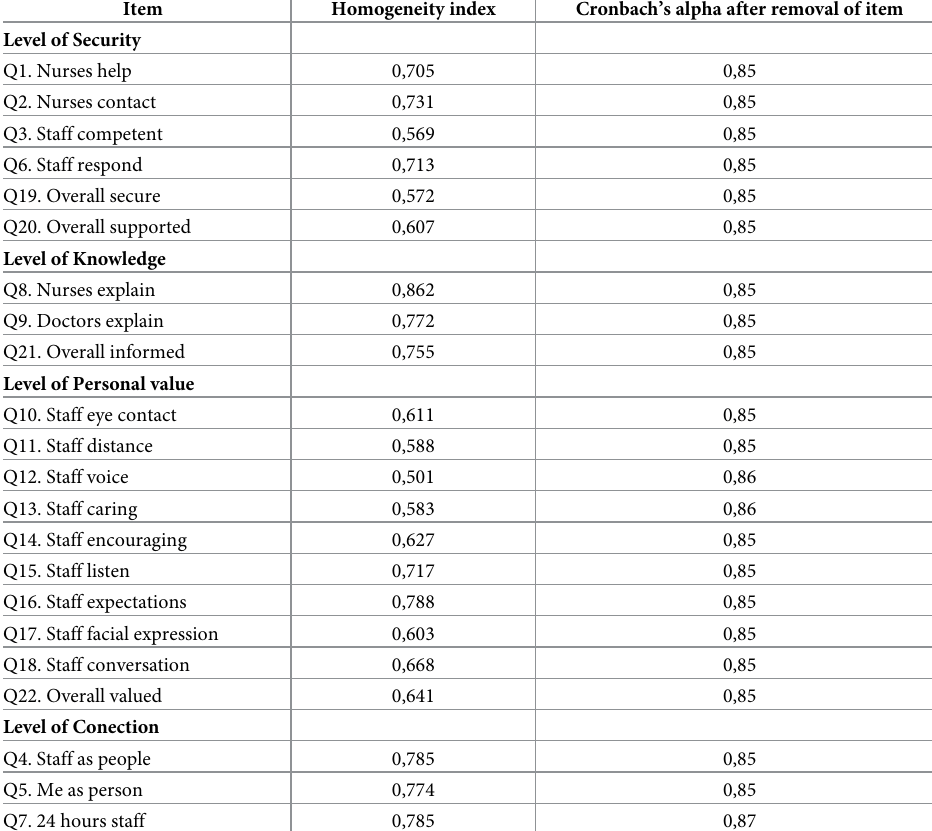
Table 6. Homogeneity index of each question and internal consistency of the PEECH questionnaire after elimina- tion of the question.